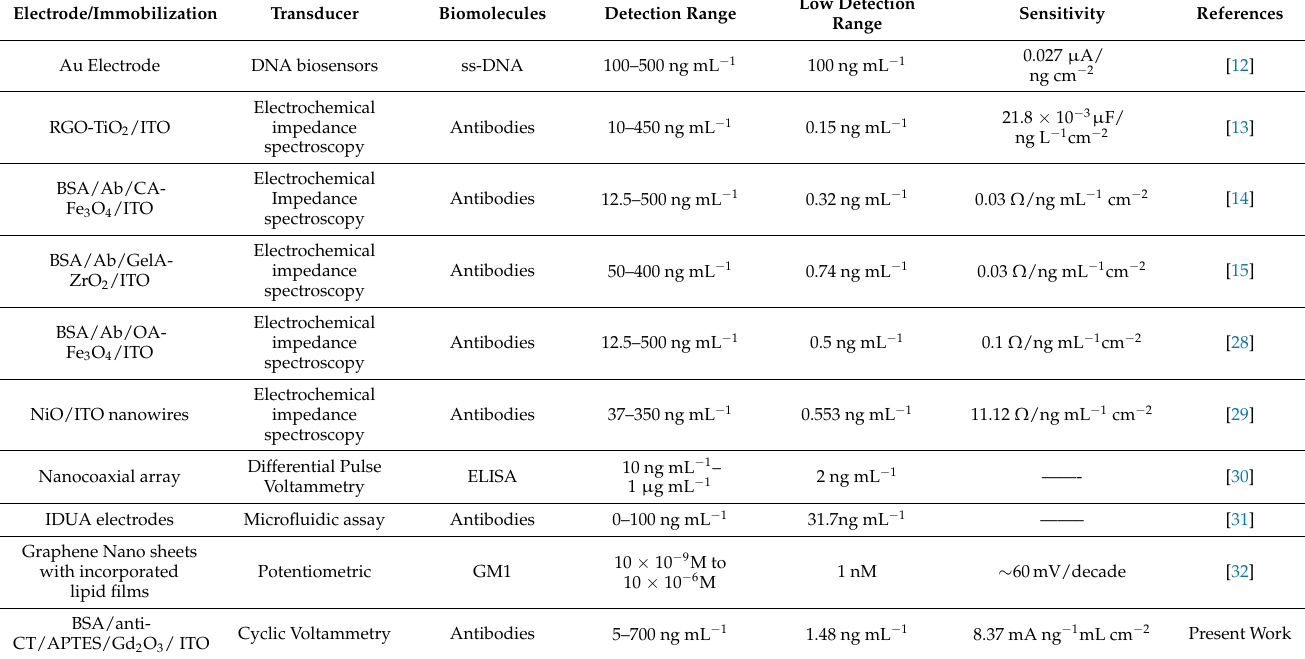
Table 1. Comparison of biosensing properties of the BSA/anti-CT/APTES/Gd 2 O 3 /ITO immunoelec- trode reported in the